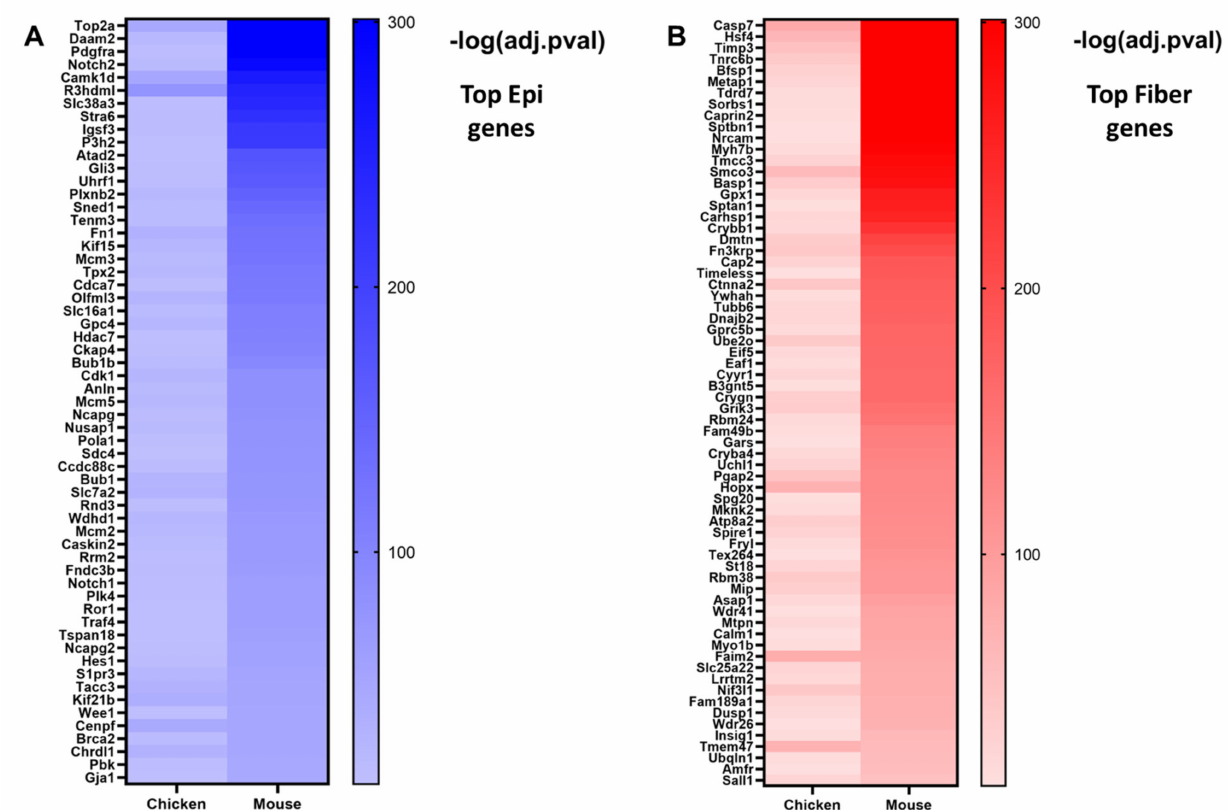
Figure 6. The top differentially expressed genes in mouse and chicken lens differentiation. Genes were classified as either epithelial cell genes (log2FC < 0, q < 0.05) or fiber cell genes (log2FC > 0, q < 0.05) and then ranked from lowest to highest q-value. ( A ) A heatmap showing genes in the top 200 epithelial cell genes in both E13 chicken and E16.5 mouse lenses. ( B ) A heatmap showing genes in the top 200 fiber cell genes in both E13 chicken and E16.5 mouse lenses. Darker colors represent smaller